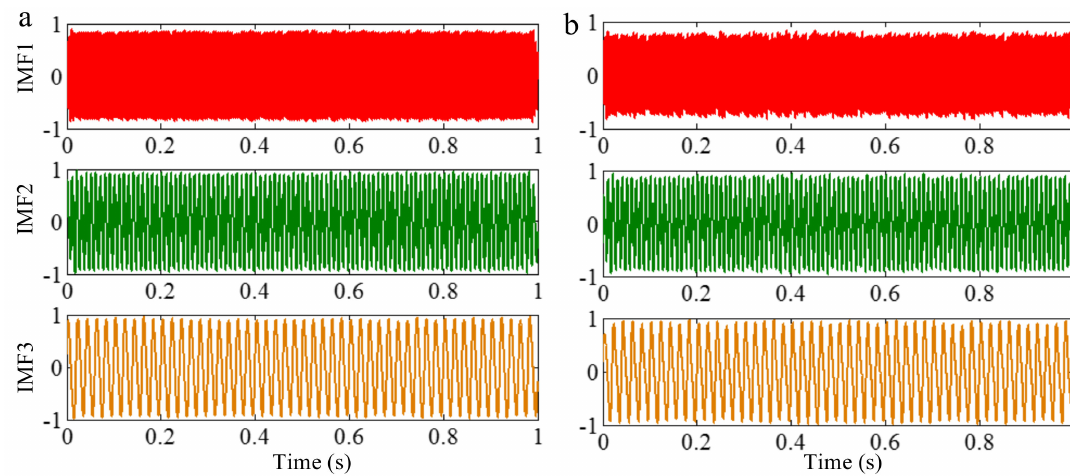
Figure 17. The waveforms of the IMFs 1–3 of f sig 3 by EEMD and CEEMD: ( a ) EEMD and ( b ) CEEMD.